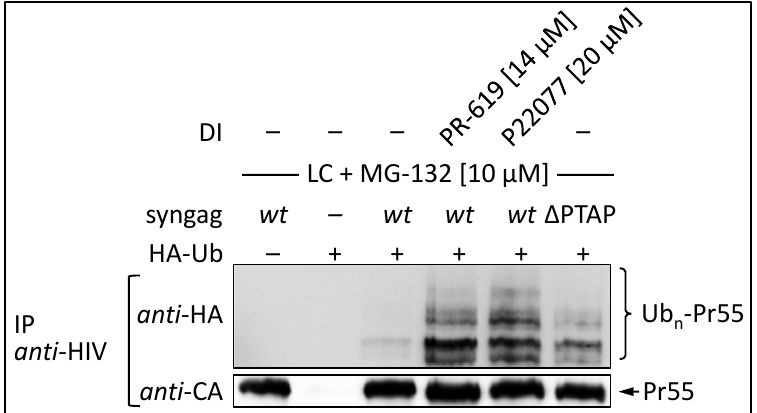
Figure 8. Treatment with the DIs PR-619 or P22077 leads to enhanced HIV-1 Gag ubiquitination. HeLa cells were co-transfected with HA-tagged ubiquitin and syngag wt or ∆PTAP expression plasmids. Twenty-four hours post transfection cells were treated with 14 μM PR-619 or 20 μM P22077 for 12 h, as well as with 10 μM LC and MG-132, 5 h before immunoprecipitation. Gag was immunoprecipitated from whole cell lysates using anti-HIV antibodies and Gag ubiquitination was detected by western blot stained for HA. The amount of precipitated Gag was detected by anti-CA staining.